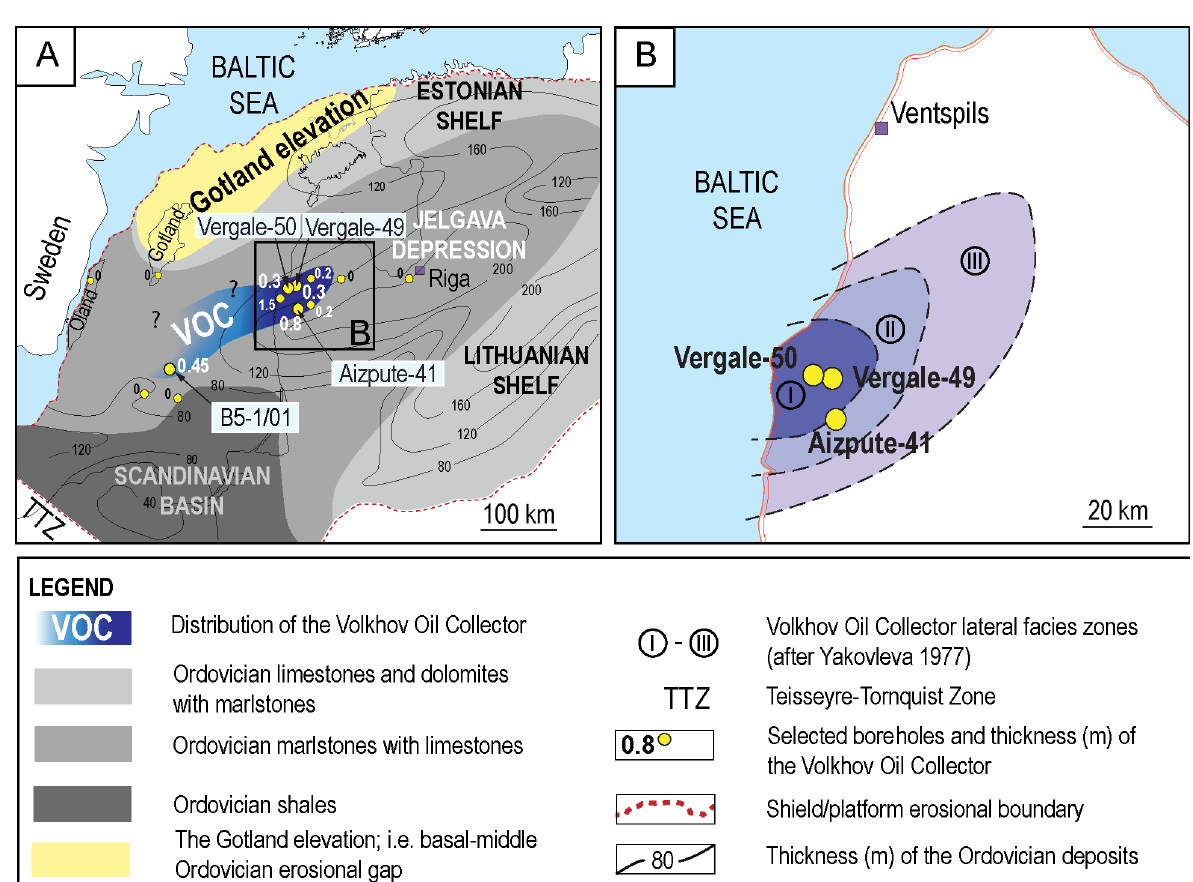
Fig. 1. Location of the study region. A , Ordovician marine deposits in Baltoscandia with general facies distribution and thickness (isopachs by Poprawa et al. 1999). The distribution area and thickness of the Volkhov Oil Collector bed are based on drill core data by Yakovleva (1977) and Dom ż alski et al. (2004). The basal Middle Ordovician erosional gap area (i.e. the ‘Gotland elevation’) is modified from Suuroja et al. (2003). B , sketch-map showing the lateral facies distribution (facies I–III) of the Volkhov Oil Collector (after Yakovleva 1977) with localities of the studied drill